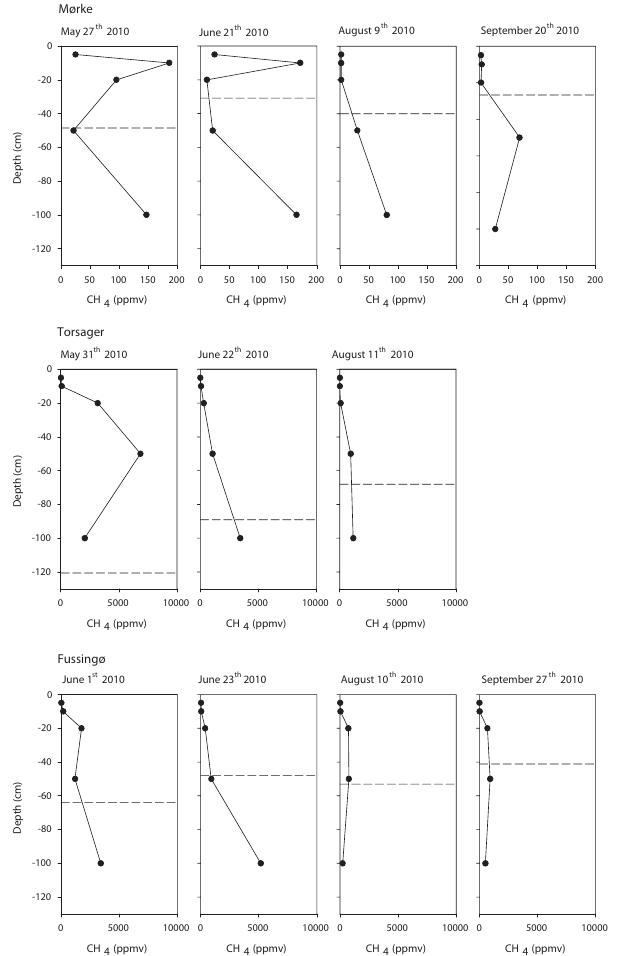
Figure 3. Soil methane (CH 4 ) molar fraction profiles for the three different sites at the four sampling dates. The dashed line represents the groundwater level. For Torsager measurements were not taken on the last sampling day due to excessive surface flooding. Note the different x axis scale for Mørke.